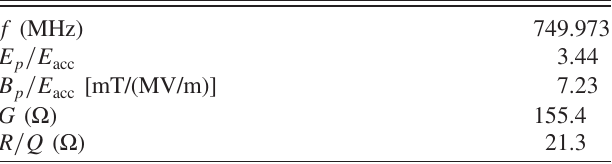
TABLE I. Summary of the electromagnetic parameters of the single-cell